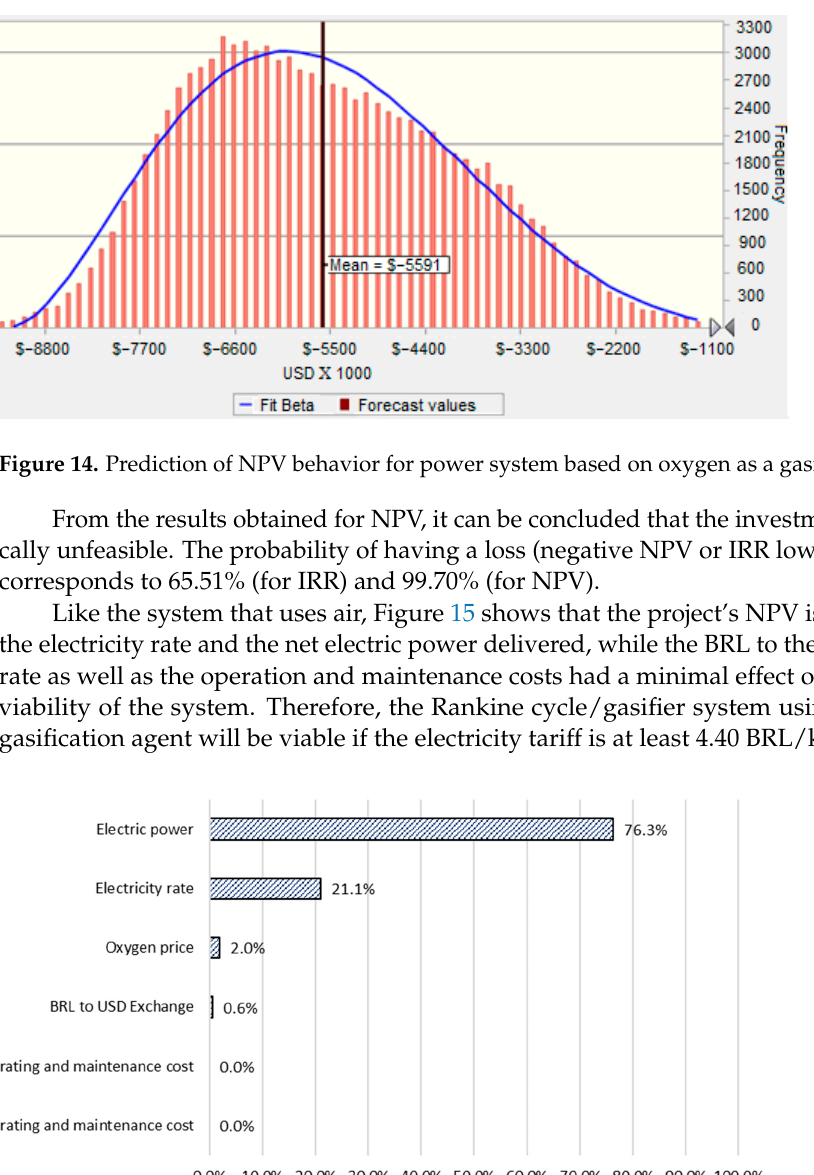
Figure 13. Assumption contribution to NPV variance of power system based on air as a gasifica- tion agent. Based on the discount rate, investment and expenses value segregation, as well as